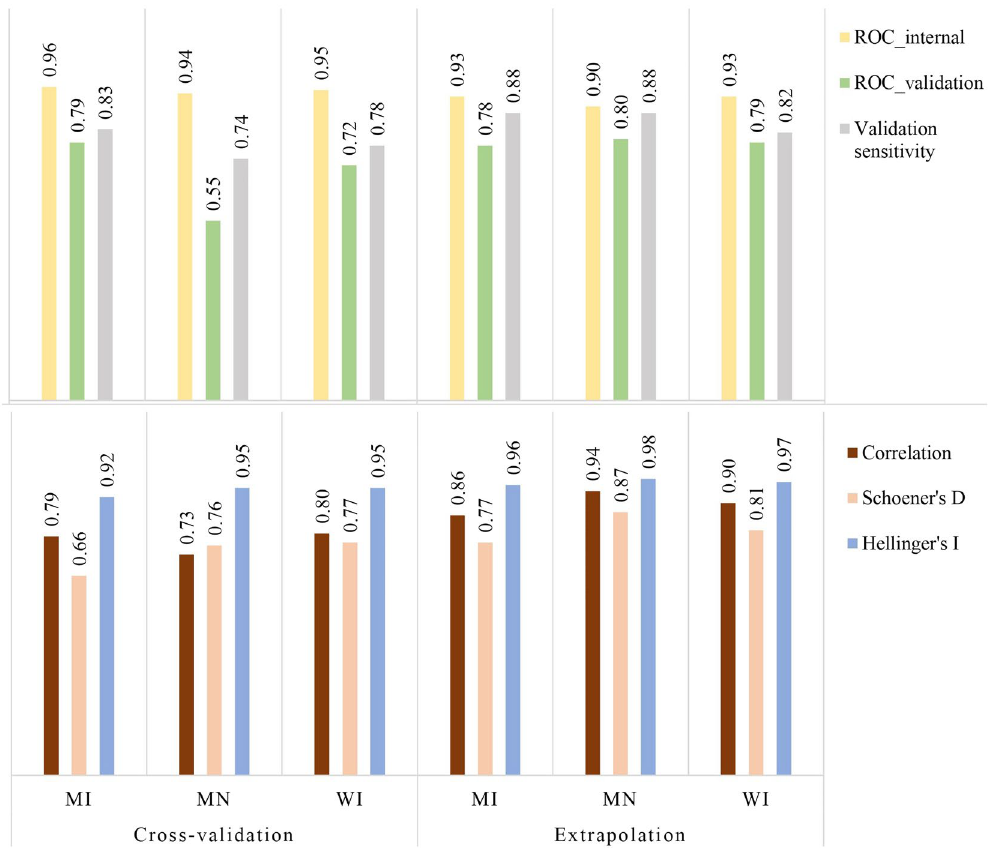
Figure 3. Performance metrics for the single-state distribution models (see “Methods”, Fig. 2) for wolves, western Great Lakes region, USA, 2017–2020. ROC_internal = area under the curve of an operator characteristic curve (ROC) for wolf calibration locations, ROC_validation = ROC for wolf validation locations, Validation sensitivity = proportion of correctly predicted wolf presence locations within the validation data, Correlation = Spearman’s r in relation to the regional model, Schoener’s D and Hellinger’s I = niche similarity metrics with the regional model (0 = no overlap, 1 = complete overlap, see “Methods”), MI Michigan, MN Minnesota, and WI Wisconsin.